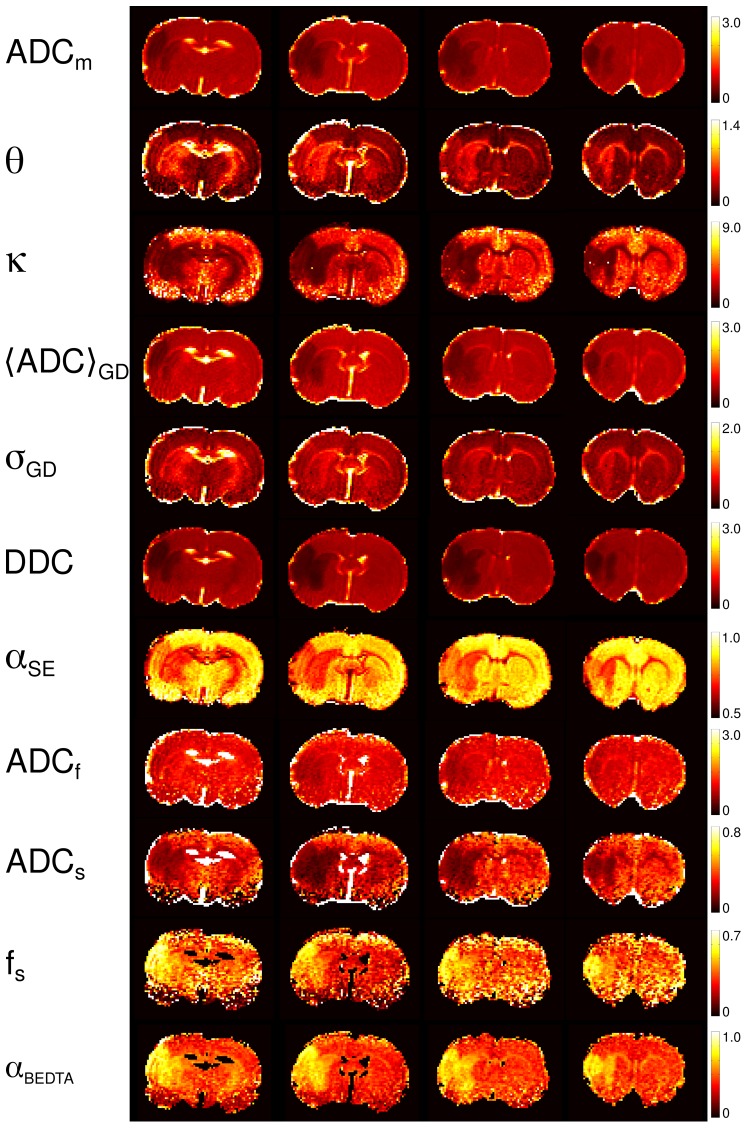
Parameter maps (animal 1).The maps of the investigated model parameters of the four slices in animal 1. The numbers on the scale bars that refer to ADCm, θ, , DDC, ADCf, and ADCs, are in units ms−1 µm2.